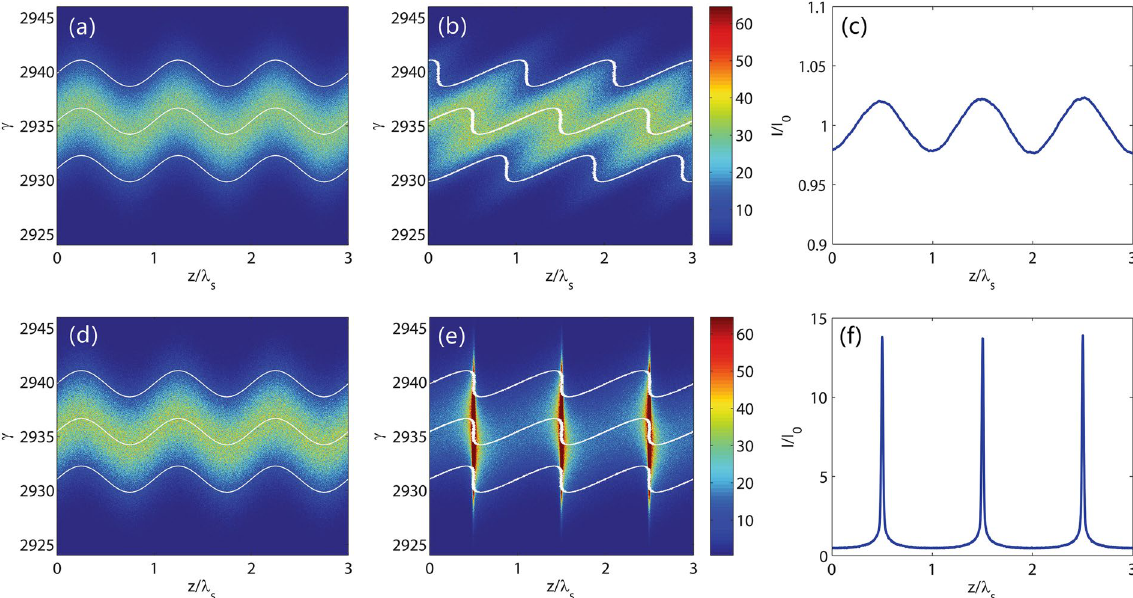
Figure 2. Comparison of the mechanisms of the conventional CHG and the proposed scheme. Longitudinal phase space distributions at the exits of the modulator ( a ) and the dispersion section ( b ) and the corresponding current distribution ( c ) in the conventional CHG. Longitudinal phase space distributions at the exits of the modulator ( d ) and the dispersion section ( e ) and the corresponding current distribution ( f ) in the proposed scheme. Three electron slices have been highlighted to show the principle. With a very small energy modulation of about 0.4 times of the initial beam energy spread, sharp coherent mocrobunchings can be generated via the proposed scheme. The corresponding bunching factor is very high for high